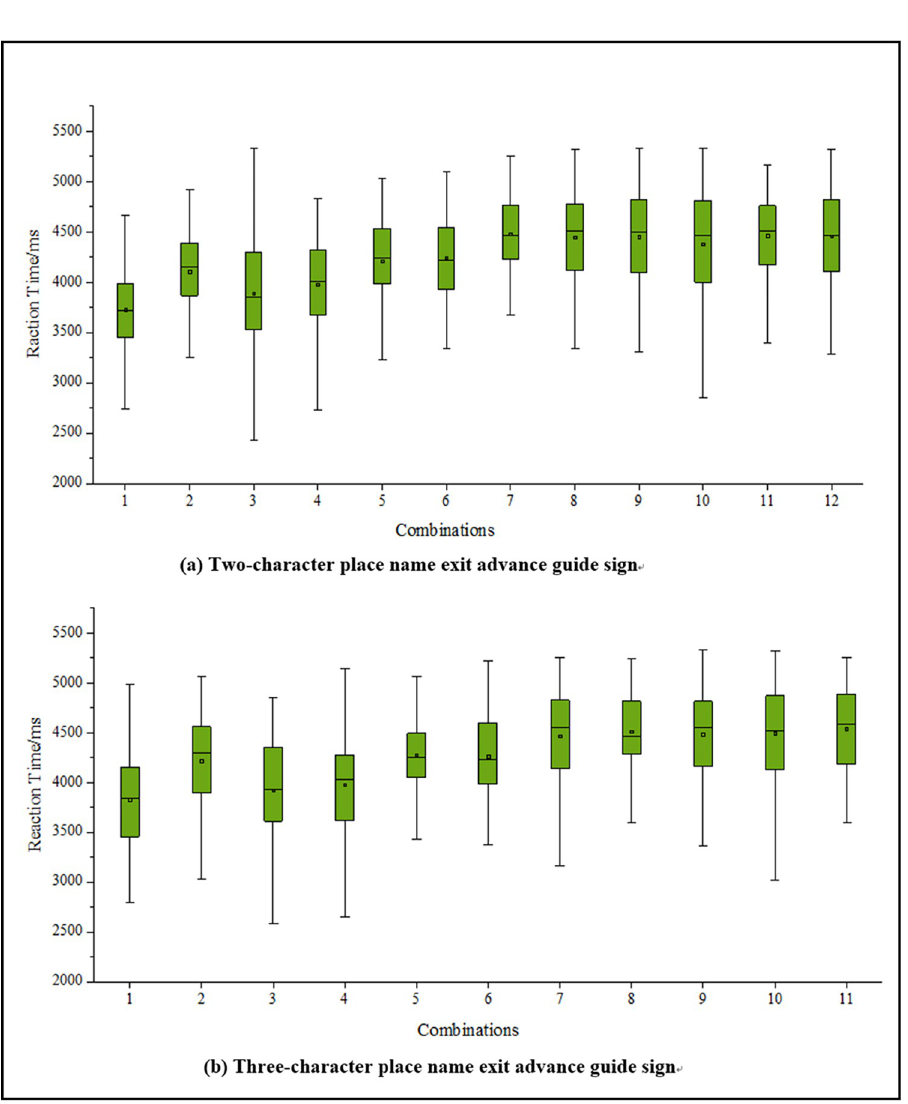
Fig 8. The average reaction time of drivers’ recognition of exit advance guide signs under different information